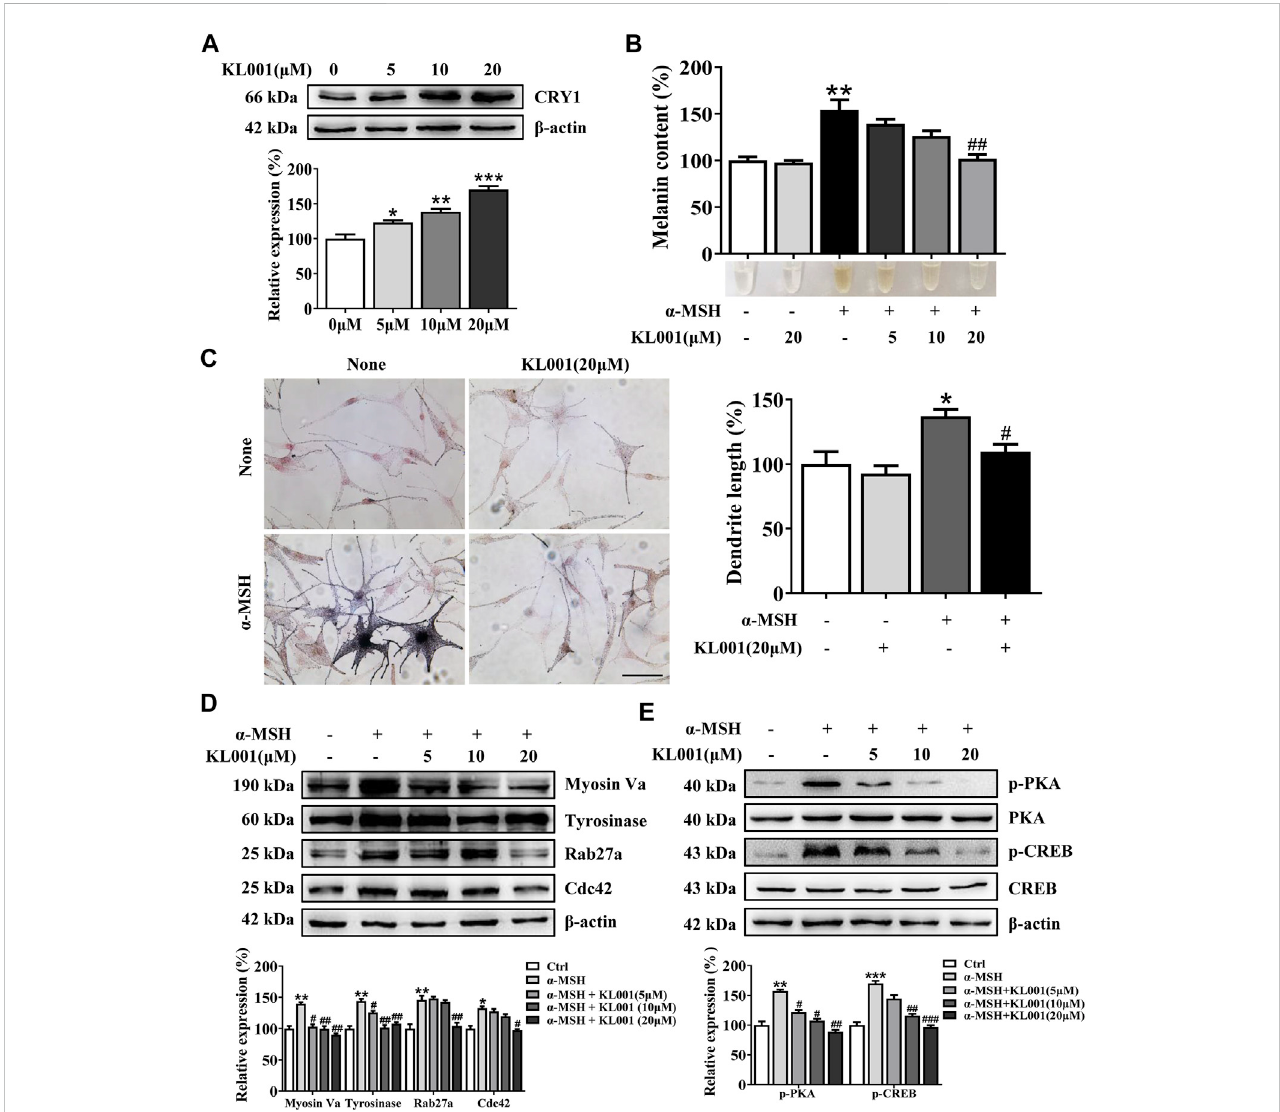
FIGURE 6 KL001inhibitedmelanogenesisinhumanmelanocytes. (A) HumanmelanocytesweretreatedwithKL001for48 handCRY1expressionwasmeasuredby western blot analysis. (B) Melanin contents were measured as described in methods. (C) Human melanocytes were stained with Fontana-Masson staining. Bar = 20 μ m. Total length of dendrites per cell was measured on the pictures using ruler. (D) Expression of tyrosinase, Myosin Va, Cdc42 and Rab27a were measured using western blotting as described in methods. (E) Phosphorylation level of PKA and CREB were detected. Human melanocytes were pretreated with KL001 for 2 h and stimulated with α -MSH for 20 min in the presence of KL001. Data are expressed as the mean ± SD ( n = 3). * p < 0.05, ** p < 0.01, *** p < 0.001 versus non-treated cells. # p < 0.05, ## p < 0.01, ### p < 0.0001 versus α -MSH -treated